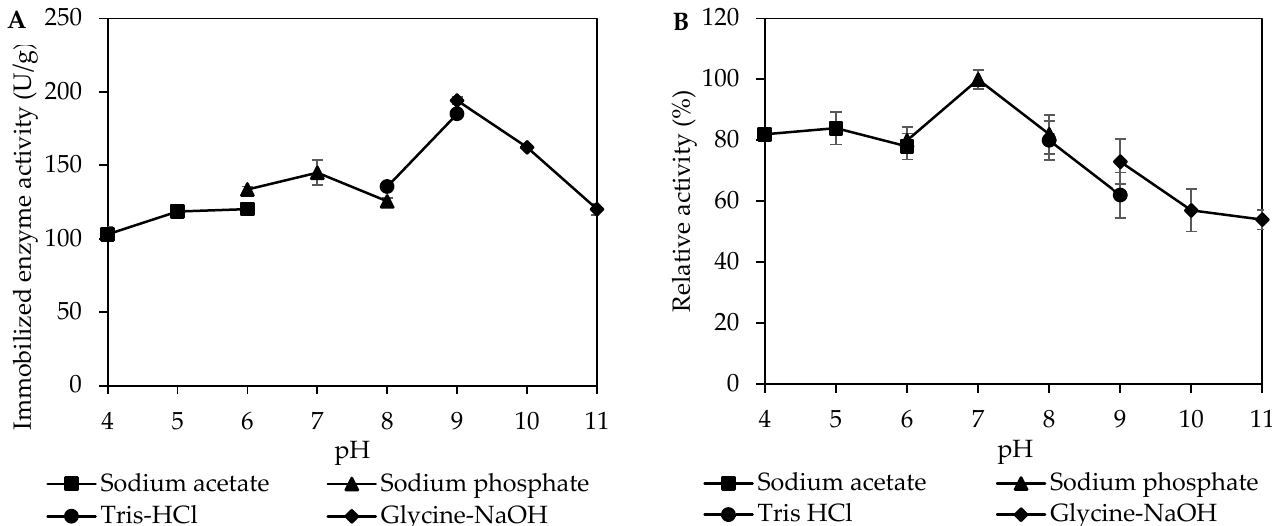
Figure 4. Characterization of immobilized carboxylic acid reductase from Mycobacterium phlei ( Mp CAR). The effect of pH on the activity ( A ) and stability ( B ) of the immobilized Mp CAR. The optimal pH and pH stability of immobilized Mp CAR were measured at different pH ranges from pH 4 to 11. Samples were measured in triplicates.